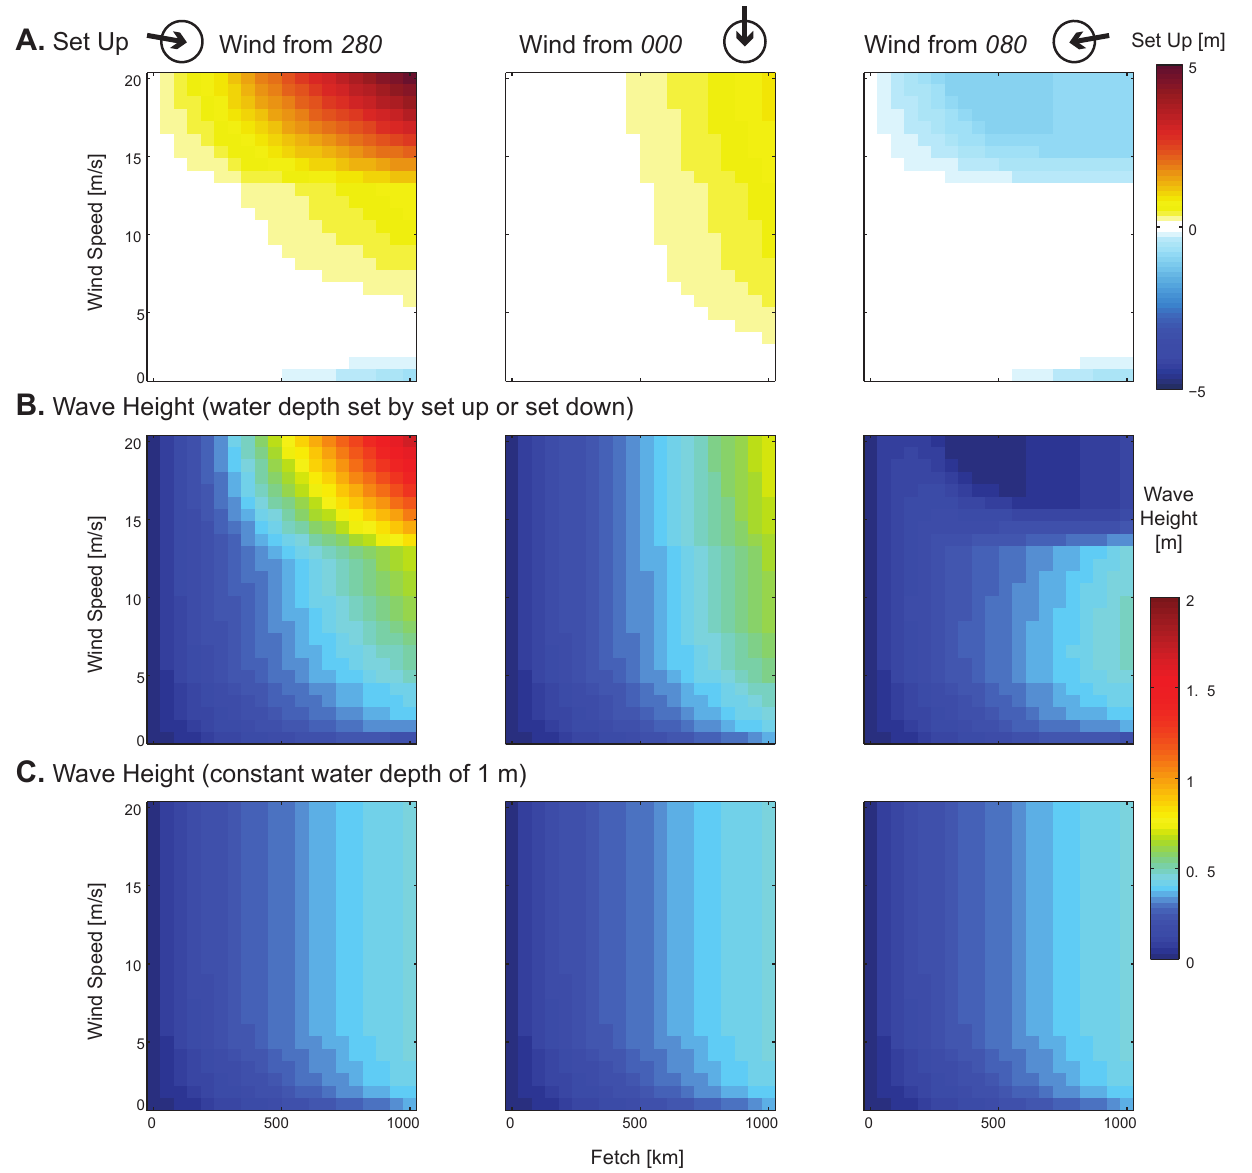
Figure 11. Theoretical setup in 1m mean water depth (a) , wave height calculated in water depth modulated by set up (b) , and wave height (c) with a constant water depth at 1m for an east–west oriented coastal shelf. Wind from the west and the north sets water levels up while wind from the east sets water down. Neither setup nor wave height saturate at a critical